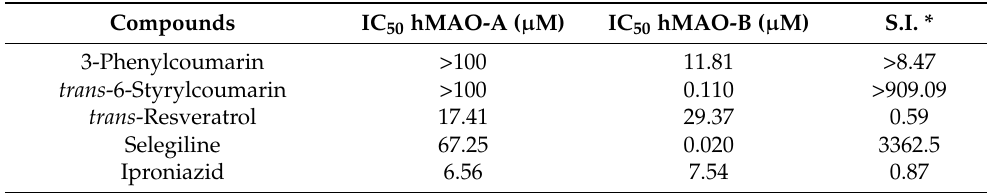
Table 1. Experimental h MAO-A and h MAO-B IC 50 values of the studied compounds and trans - resveratrol (reference inhibitor), using recombinant h MAO isoforms expressed in baculovirus-infected BTI insect cells (BTI-TN-5B1-4), and h MAO-B selectivity index. Compounds